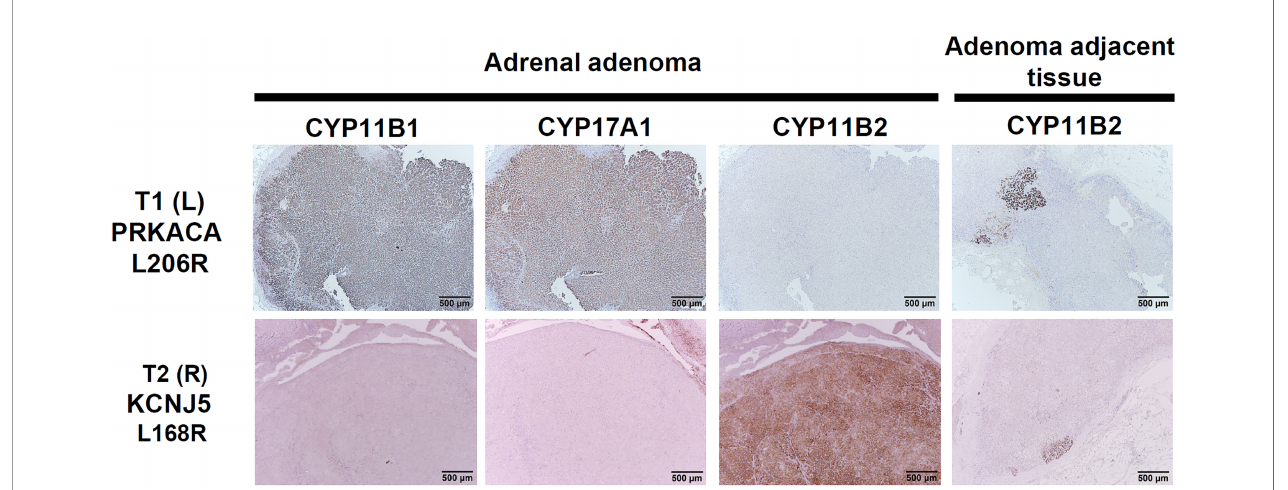
FIGURE 1 | Immunohistochemical staining of CYP11B2, and CYP11B1, and CYP17A1 in the left adrenal mass with the PRKACA mutation (upper row) and the right classical APA with KCNJ5 mutation (bottom row). Of note, bilateral positive mAPM staining was demonstrated. Left adenoma harboring the PRKACA L206R mutation is mostly composed of lipid-poor compact cells with intense expression of CYP11B1 and CYP17A1, and negative expression of CYP11B2. Right adenoma harboring the KCNJ5 L168 mutation is mostly composed of lipid-poor compact cells with intense expression of CYP11B2. Scale bar, 500 m